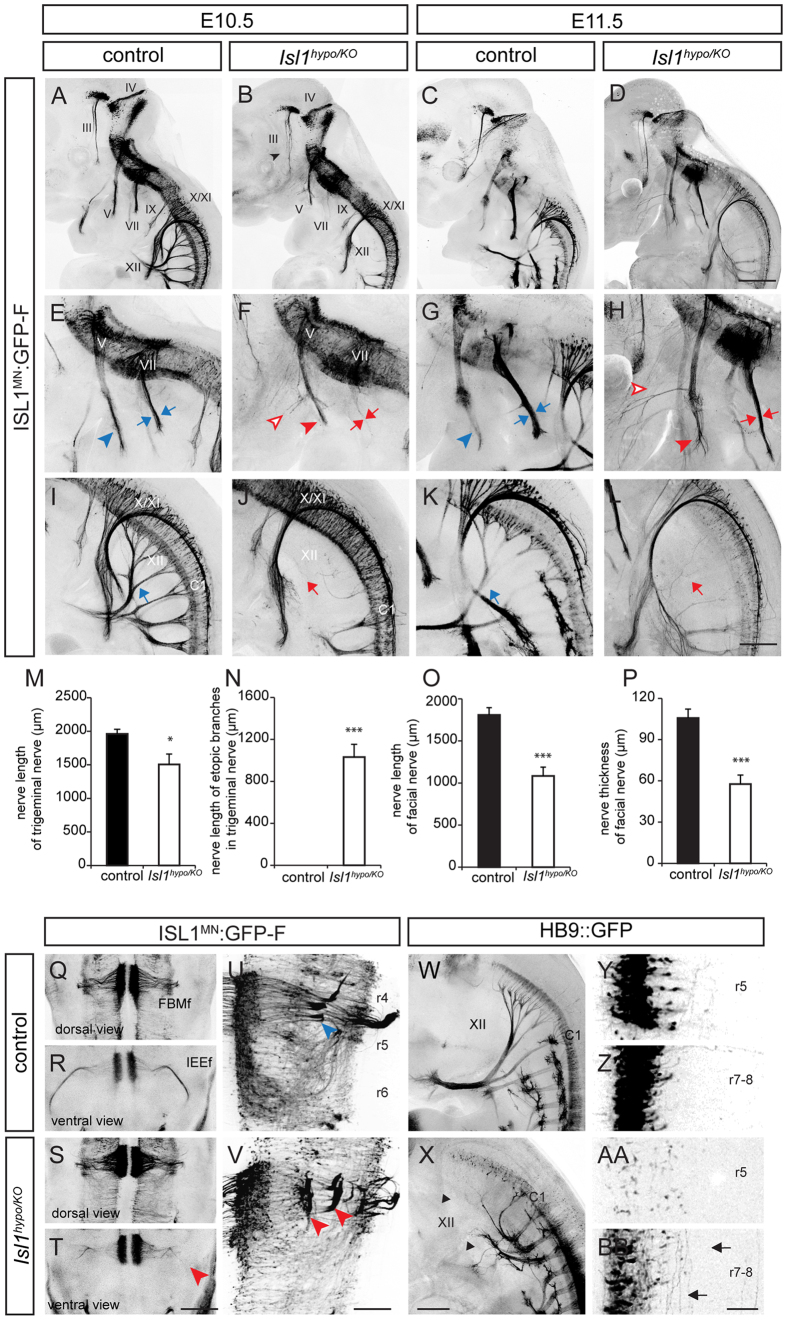
Axon defects of cranial MNs in Isl1hypo/KO mice.(A–D) Wholemount GFP immunostaining of E10.5 and E11.5 ISLMN: GFP-F reporter embryos. Oculomotor axons of Isl1hypo/KO mice are defasciculated at E10.5 (arrowhead, B). (E–L) Magnified views of images in (A–D). The trigeminal mandibular (V) nerves of Isl1hypo/KO mice are defasciculated (arrowhead in E,G vs arrowhead in F,H) and develop ectopic branches (open arrowheads, F,H). The facial nerve (VII) are fewer (arrows in E,G vs arrows in F,H) and the hypoglossal nerve (XII) is absent (arrow in I,K, arrow in J,L) (E10.5: n ≥ 3; E11.5: n ≥ 7; number of embryos). (M–P) Quantification of nerve length and thickness of axons. Error bars represent s.e.m. *p < 0.05, ***p < 0.001, unpaired Student’s t-test. (Q–T) Open-book flat-mount preparation of E11.5 hindbrains. IEE projections are short and disorganized in Isl1hypo/KO mice (arrowhead, T) (control: n = 5; Isl1hypo/KO mice: n = 3; number of embryos). (U,V) Flat-mounted preparation of E11.5 hindbrains. Migration of FBM neurons is arrested in r5 and their exit points are disrupted (arrowhead in U vs arrowheads in V) (control: n = 4; Isl1hypo/KO mice: n = 3; number of embryos). (W,X) Whole-mount views of E11.5 Hb9::GFP mice. Axons of hypoglossal (XII) neurons and spinal cord MNs in Isl1hypo/KO mice are severely reduced or missing (arrowheads) (control: n = 4; Isl1hypo/KO mice: n = 3; number of embryos). (Y-BB) Flat-mount views of E11.5 Hb9::GFP hindbrains. The abducens neurons in r5 and SM somata are reduced and the interneuron-like longitudinal projections were found in the Isl1hypo/KO mice (arrows, BB) (control: n = 5; Isl1hypo/KO mice: n = 2; number of embryos). III, oculomotor; (V) trigeminal mandibular; VII, facial nerve; IX, glossopharyngeal; X, vagal; XI, spinal accessory; XII, hypoglossal nerve; FBMf, facial branchio motor neuron fibers; IEEf, inner ear efferent fibers. Scale bars: in (D), 500 μm for (A–D) in (L), 250 μm for (E–L) in (T), 500 μm for (Q–T) in (V), 200 μm for (U,V) in (X), 250 μm for (W,X) in (BB), 200 μm for (Y-BB).